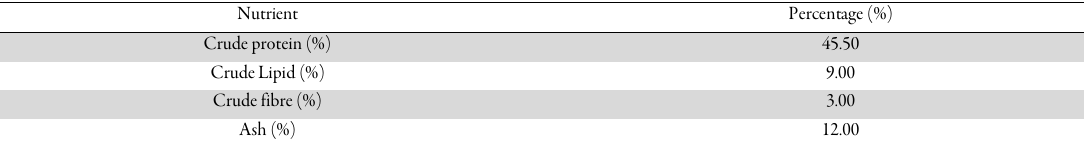
Table 1. Proximate composition of harvested maggot meal